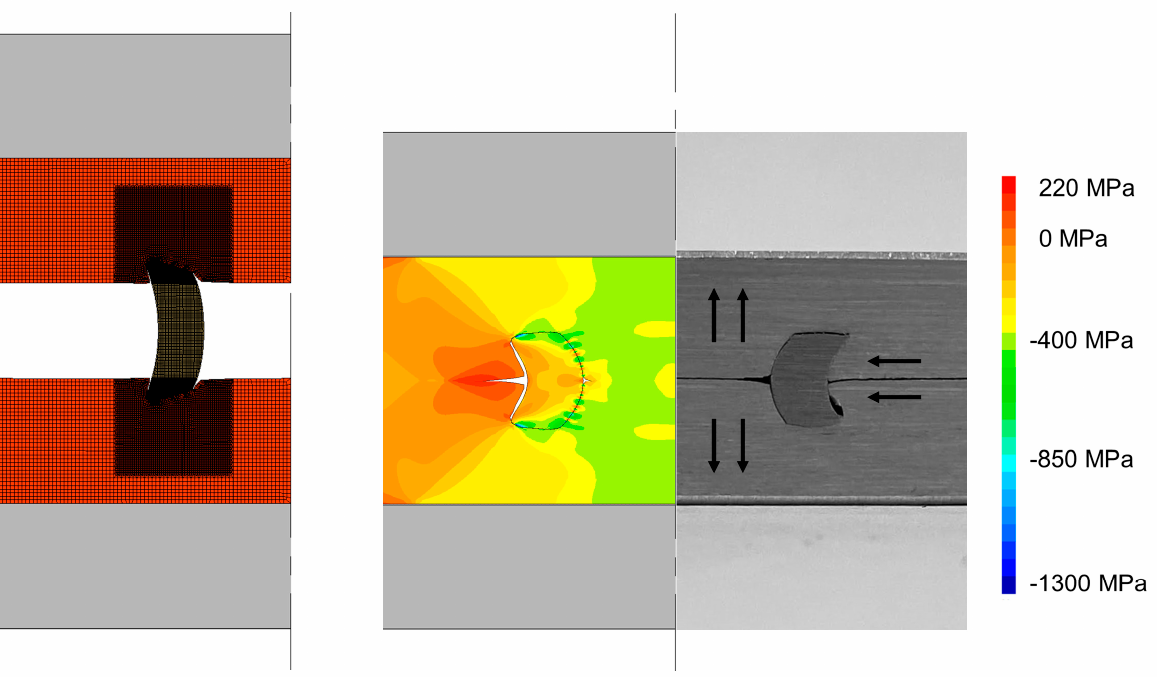
Figure 5. Evolution of conventional DSSPR with notation of the direction of material flow after elastic recovery of the materials. The distribution of radial stress σ r is